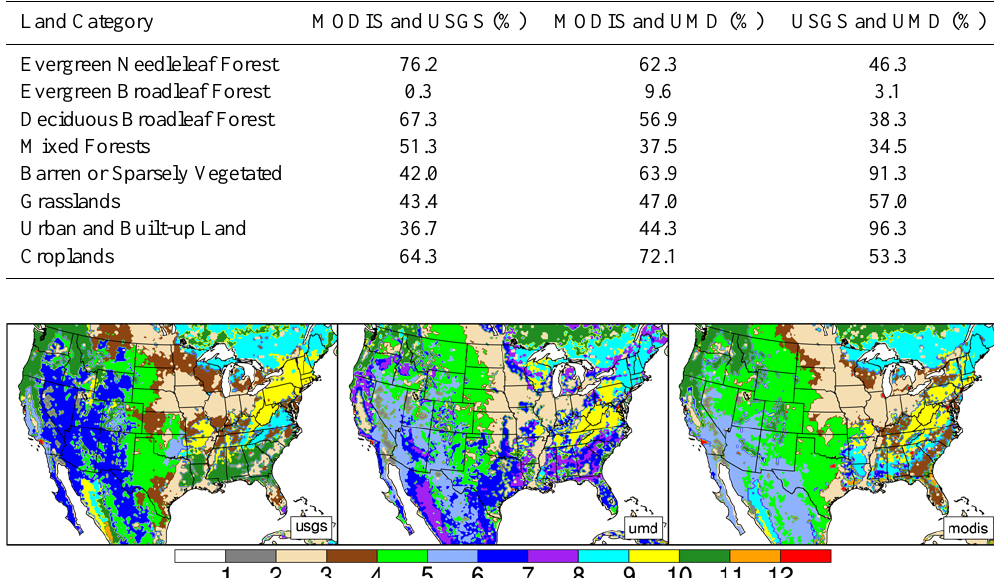
Table 1. Percentage agreements of MODIS/USGS, MODIS/UMD, and USGS/UMD for eight common land classifications.